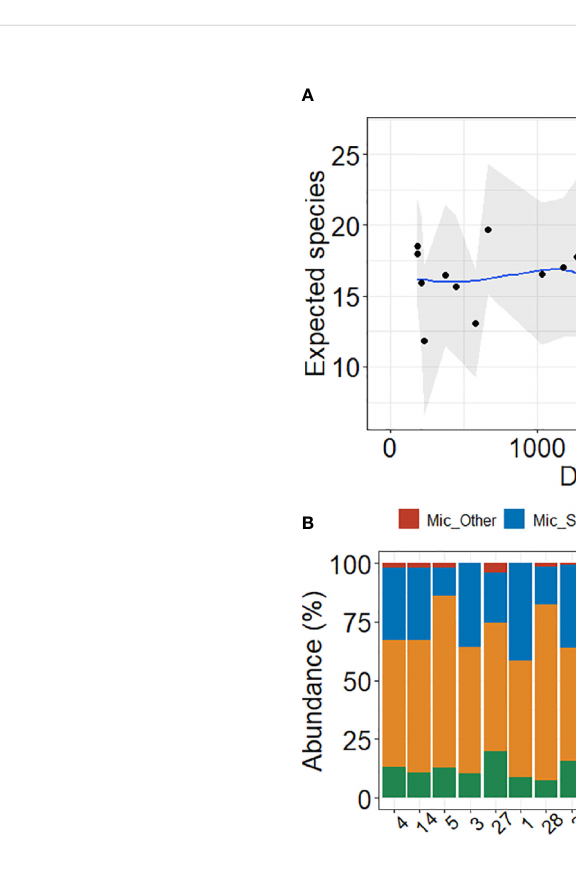
FIGURE 3 Species richness and feeding types of nematodes along a water depth gradient in 19 sites in the Southwestern Gulf of Mexico. (A) Expected number of nematode species [ES (25) ]. Shaded area indicated 0.95 con fi dence intervals generated by permutations. The best fi t curve in blue was calculated by LOESS method. (B) Relative abundance of the feeding types. Sites were ordered by depth (shallowest to the left). Mic, microbial feeders; Pred, predators; Ingest,